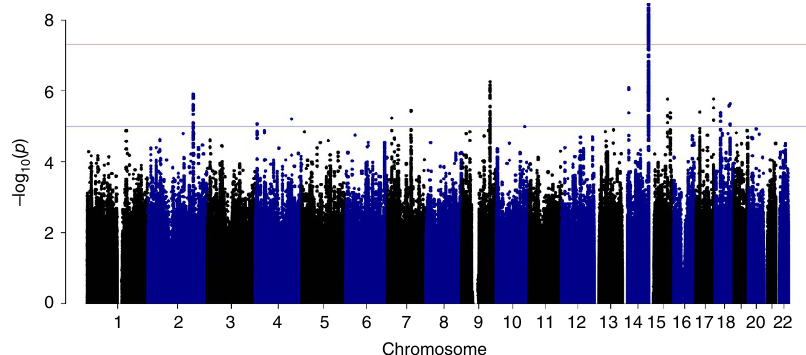
Figure 2 | Genome-wide meta-analysis for RHD susceptibility. For each variant, the negative common logarithm of the P value from an inverse-variance weighted fixed-effects meta-analysis is plotted against genomic position. The blue horizontal line indicates suggestive significance (FE meta-analysis, P ¼ 10 (cid:3) 5 ) and the red horizontal line indicates genome-wide significance (FE meta-analysis, P ¼ 5 (cid:2) 10 (cid:3) 8 ).